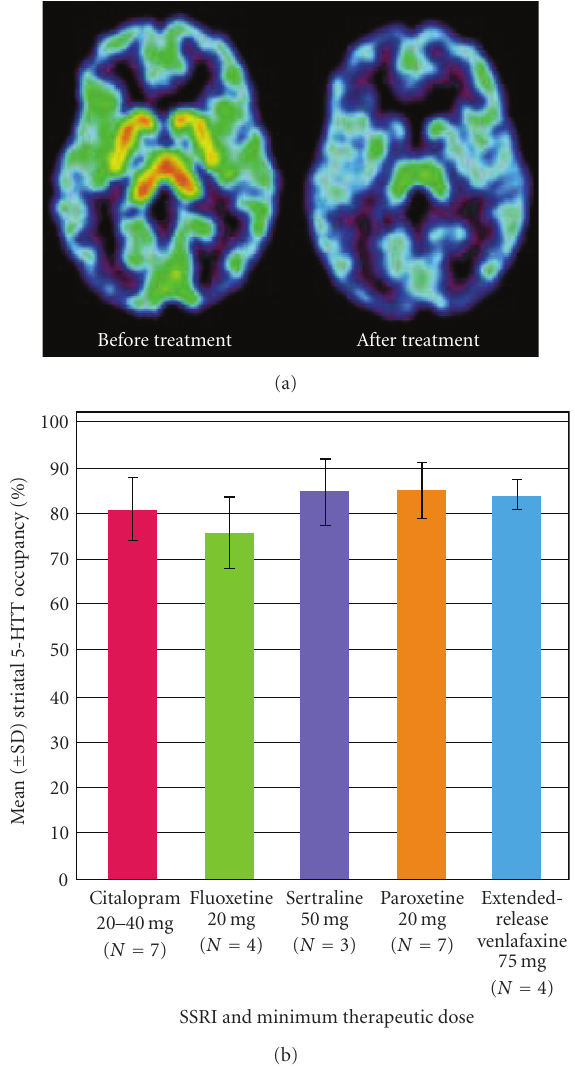
Figure 3: (a) E ff ect of citalopram on 11 C-DASB PET scan of the serotonin transporter in a depressed subject. Treatment was with 20mg/day of citalopramfor 4 weeks. Adapted from [73]. (b) Striatal serotonin transporter (5-HTT) occupancy in depressed subjects after 4 weeks of treatment at minimum therapeutic doses of five SSRIs. Adapted from